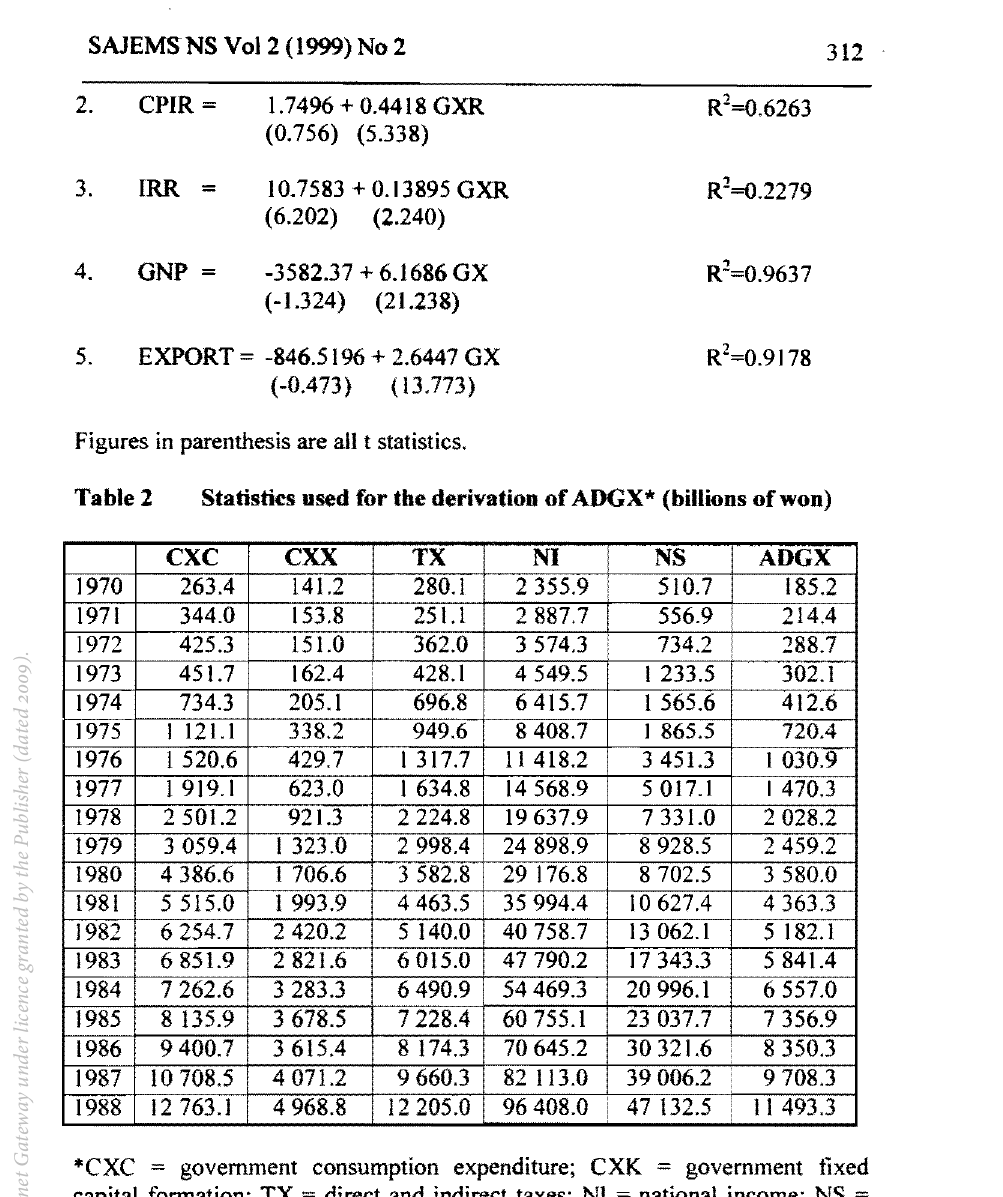
Statistics used for the derivation of ADGX· (billions of